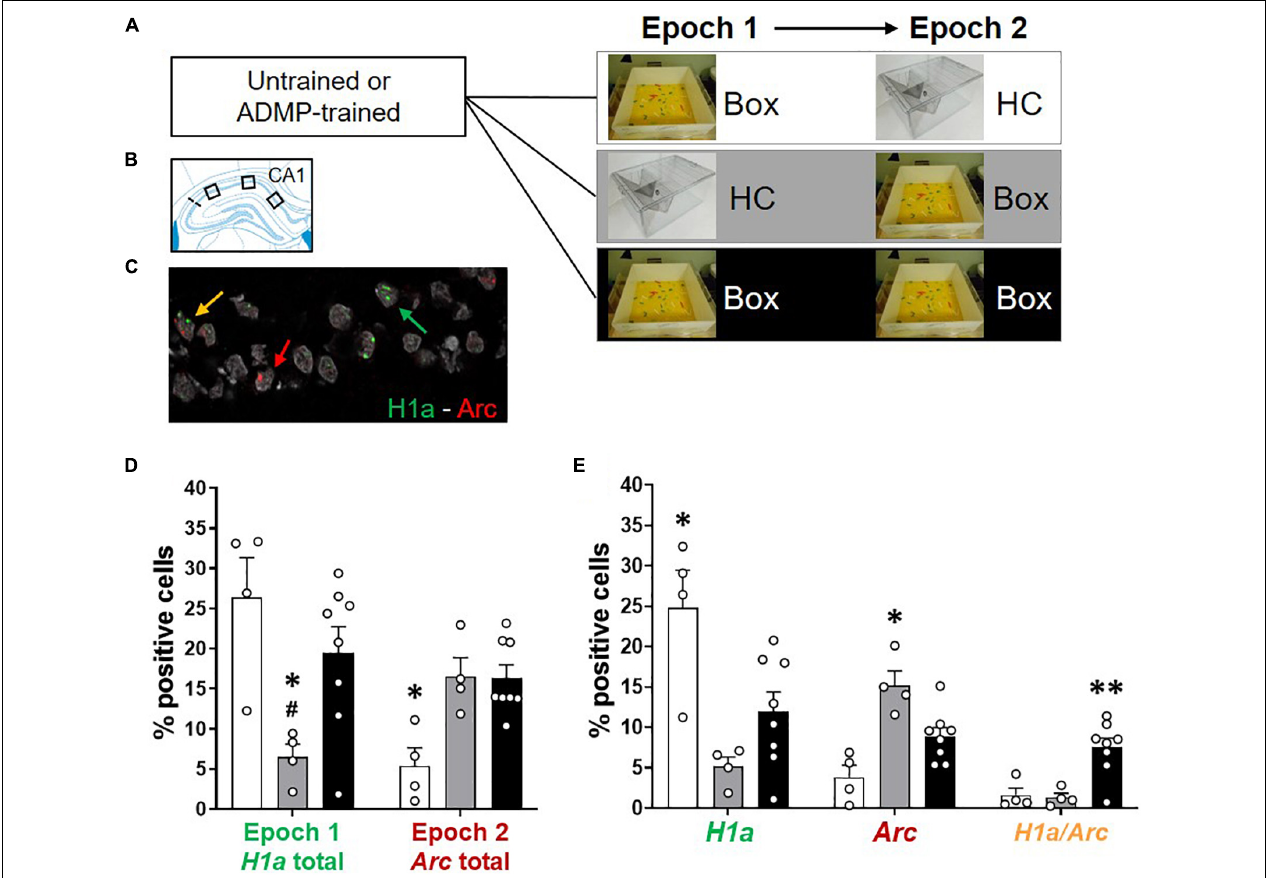
FIGURE 2 | Re-exposure to the same novel environment increases the proportion of overlapping CA1 neurons. (A) Experimental design. ADMP-trained and untrained young rats received one or two behavioral events (5-min epoch 1, 20-min delay, and 5-min epoch 2) in three groups: (1) exploration in a novel box in epoch 1 and a home cage in epoch 2 (Box – HC), (2) a home cage in epoch 1 and exploration in a novel box in epoch 2 (HC – Box), or (3) exploration in a novel box in both epochs (Box – Box). (B) Three areas of image collection in the CA1 subregion of the hippocampus. (C) An example of CA1 neurons expressing H1a (the green arrow), Arc (the red arrow), or both H1a/Arc (the yellow arrow). A scale bar: 10 µ m. (D,E) Automatic detection of overlapping CA1 neurons after re-exposure to the same novel box. (D) Left. Percentage of neurons expressing H1a (with or without co-expressing Arc ) showed increase by the novel box exploration in epoch 1. #, Box + HC vs. HC + Box, p = 0.062. Right. Percentage of neurons expressing Arc (with or without co-expressing H1a ) showed increase by the novel box exploration in epoch 2. (E) Left. Percentage of neurons expressing H1a only (without co-expressing Arc ) showed increase by novelty during epoch 1.